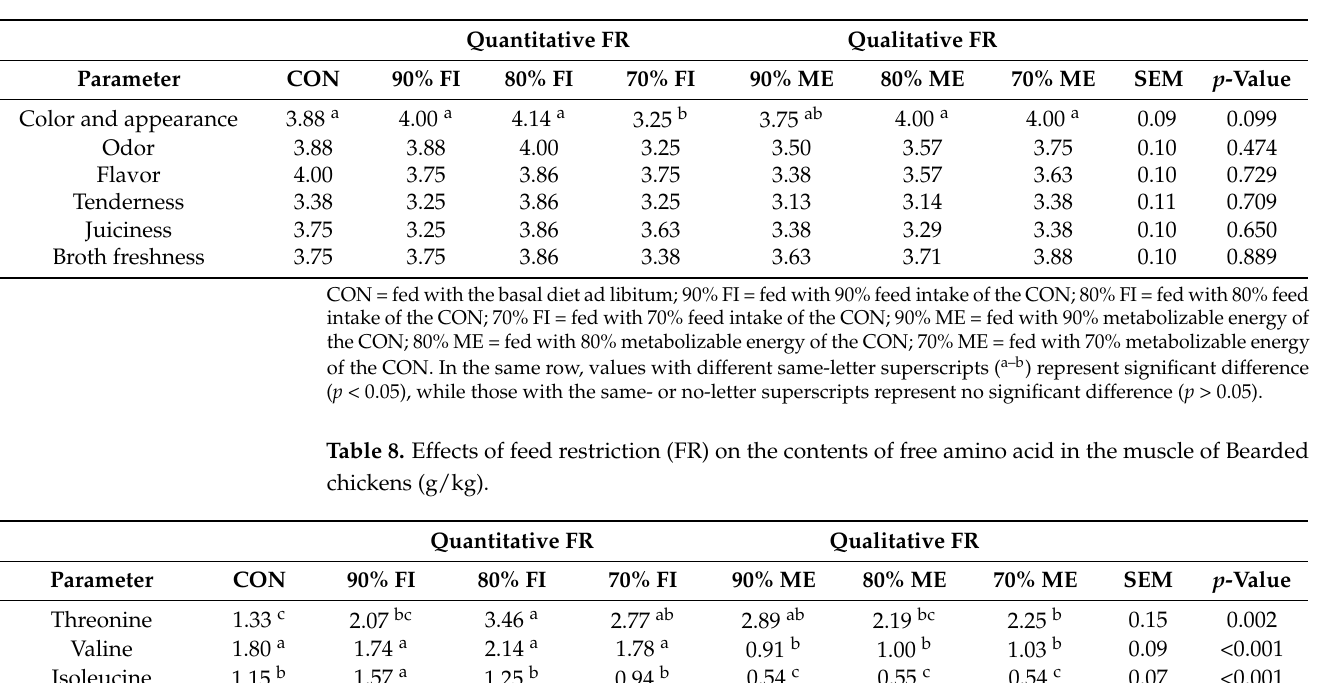
Table 7. Feed restriction (FR)-improved sensory indices of Bearded chickens.